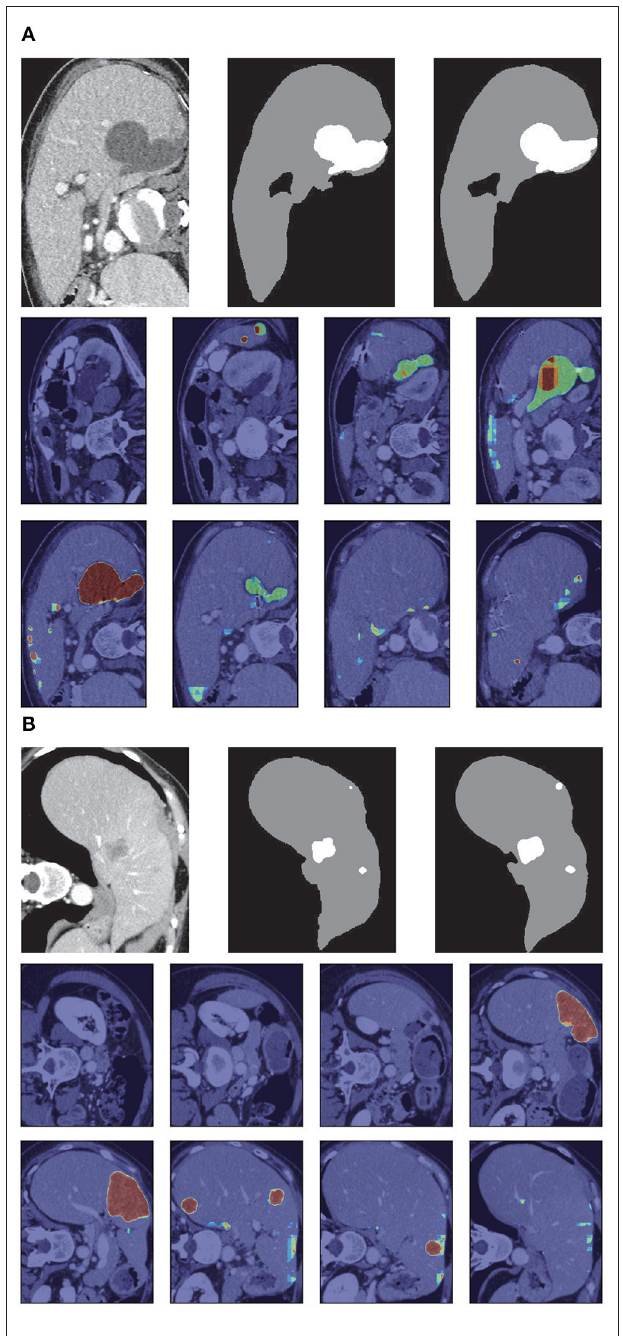
FIGURE 9 | Tumor segmentation results based on RA-UNet-II. (A) From the LiTS validation dataset, and (B) is from the 3DIRCADb dataset. From left to right, the first row of each subplots indicates the raw images, segmentation results of liver tumor, and the corresponding ground truth. The second and the third rows show the probability heat map of tumor segmentation